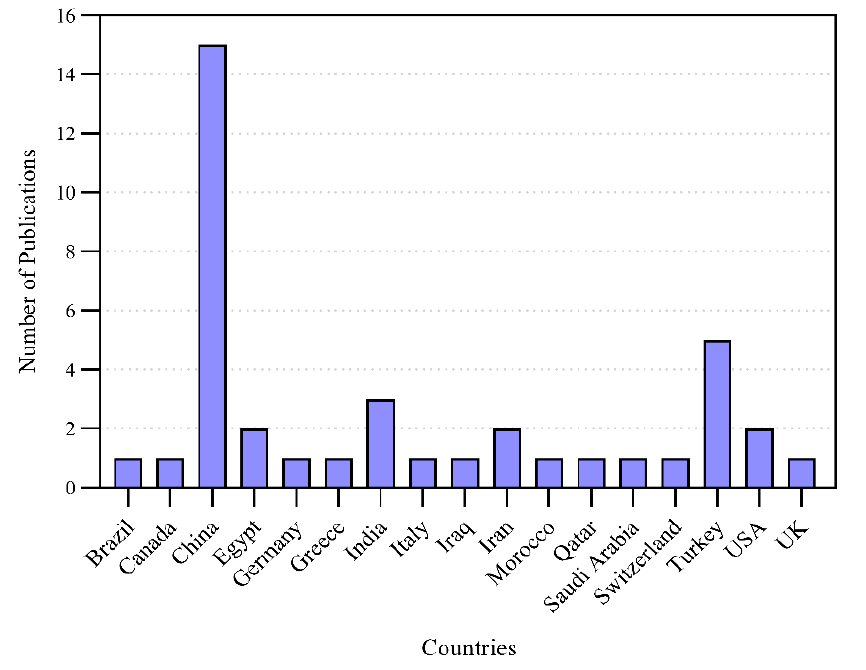
Figure 3. Distribution of published articles (ML/DL techniques for COVID-19 prediction).